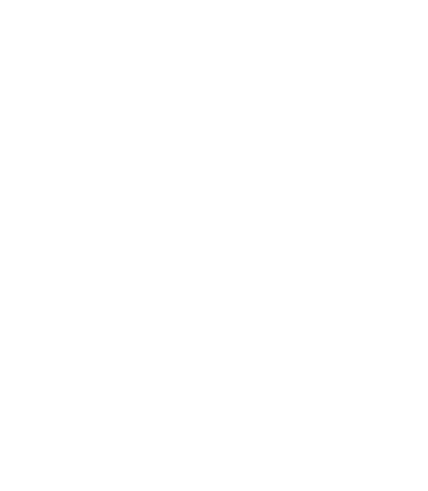
Figure 11. Compressive strength of concrete under different replacement rates of RP [27,42,74,75,81].